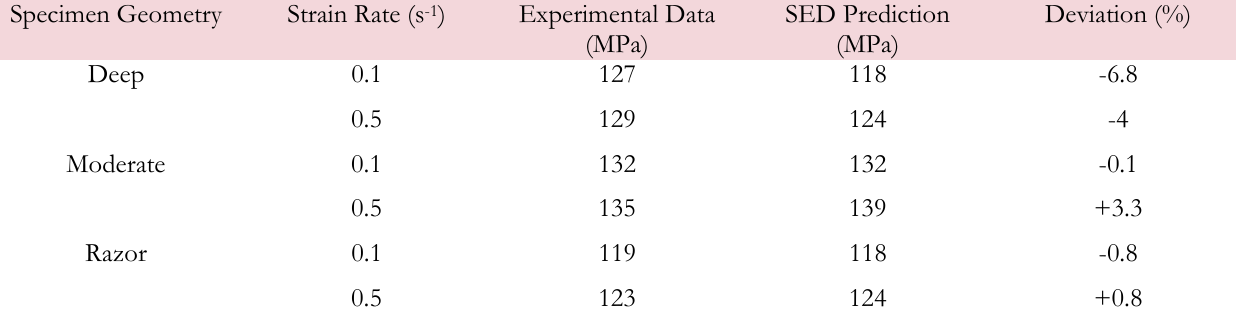
Table 3: Prediction of tensile failure of moderate, deep and razor specimens using the SED approach.